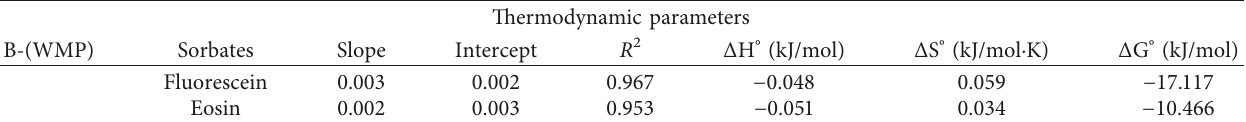
Table 10: Thermodynamic parameters of B-(WMP) sorbent. Thermodynamic